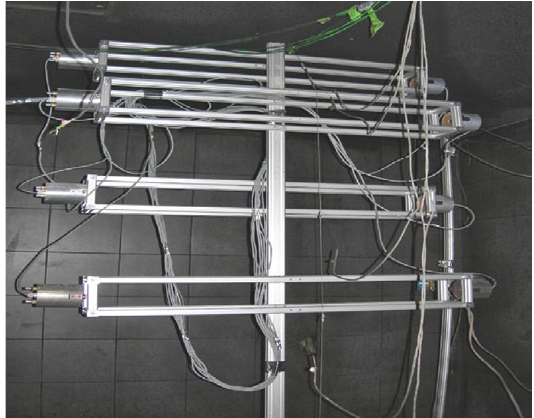
Fig. 15. A view of the column with smoke density